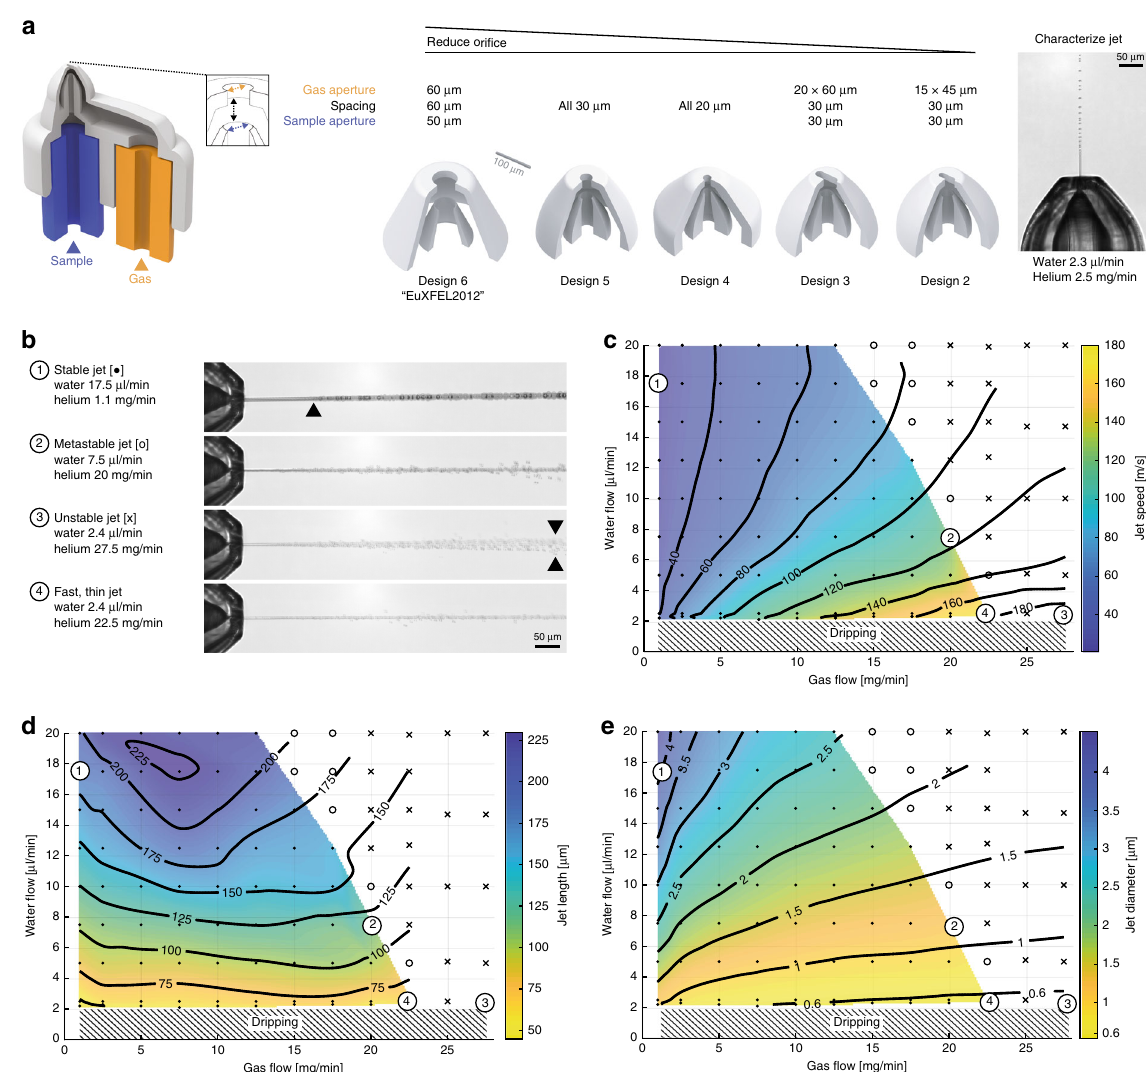
Fig. 3 Ori fi ce reduction yields thin and fast jets for low-background imaging and megahertz SFX with low sample consumption. a GDVN CAD drawing and critical ori fi ce design parameters that determine jetting performance are gas aperture, spacing, and sample aperture. While the all 30 µ m ori fi ce developed reliably during an overnight incubation, the all 20 µ m nozzle frequently failed to fully develop even after a week of incubation in PGME developer. Introducing a slit aperture combined ef fi cient overnight development with improved gas focusing performance. b Characteristic jetting modes were inferred from maximum intensity projections from ten jet image frames to highlight temporal deviations from the central jet axis (Supplementary Movies 2 – 5). A (1) stable jet (dot) continuous without fl uctuations even after the drop break-up region indicated by a black arrow. A (2) metastable jet (open circle) exhibits occasional instabilities that cause droplets to be ejected in random directions off the central jet axis. An (3) unstable jet (cross) whips around the central axis. c – e Jetting phase diagram for the 14 × 45 µ m gas ori fi ce design with the colored section highlighting the stable jetting region. Jet parameters were measured and averaged over ten images for each fl ow rate combination to interpolate heat maps. c Dual pulse iLIF illumination measured jet speeds at 1 mbar vacuum (Supplementary Fig. 3) and d observed jet lengths. e Corresponding jet diameters calculated from measured jet speeds and water fl ow rates. Fast stable jets (4) of 177 ± 13 m s − 1 speeds were observed at helium gas fl ow rates of 22.5 mg min − 1 and water fl ow rates of 2.4 µ l min − 1 and a jet diameter of 534 ± 35 nm and length of 59 ± 12 µ